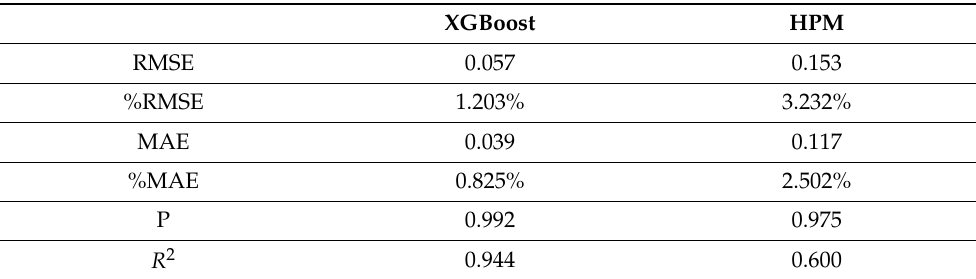
Table 2. Performance of the individual